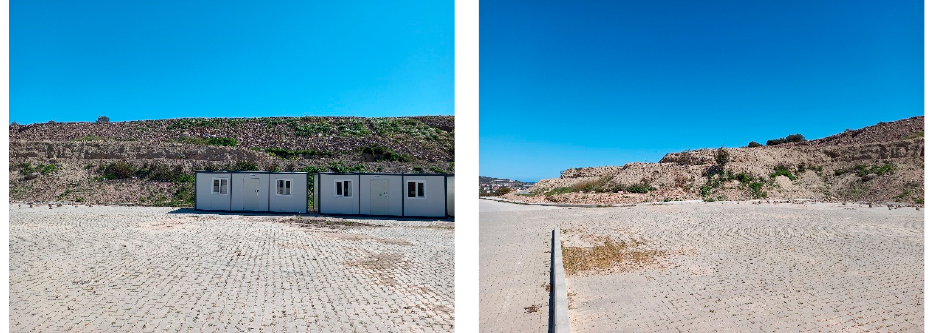
Figure 9. Erosion along the Rectorate Road.